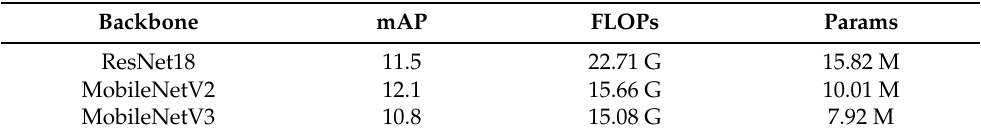
Table 3. Evaluation of simultaneous upsampling and detection module with MobileNetV2 Backbone and evaluation of the influence of the last convolutional layer in MobileNetV2 Backbone.